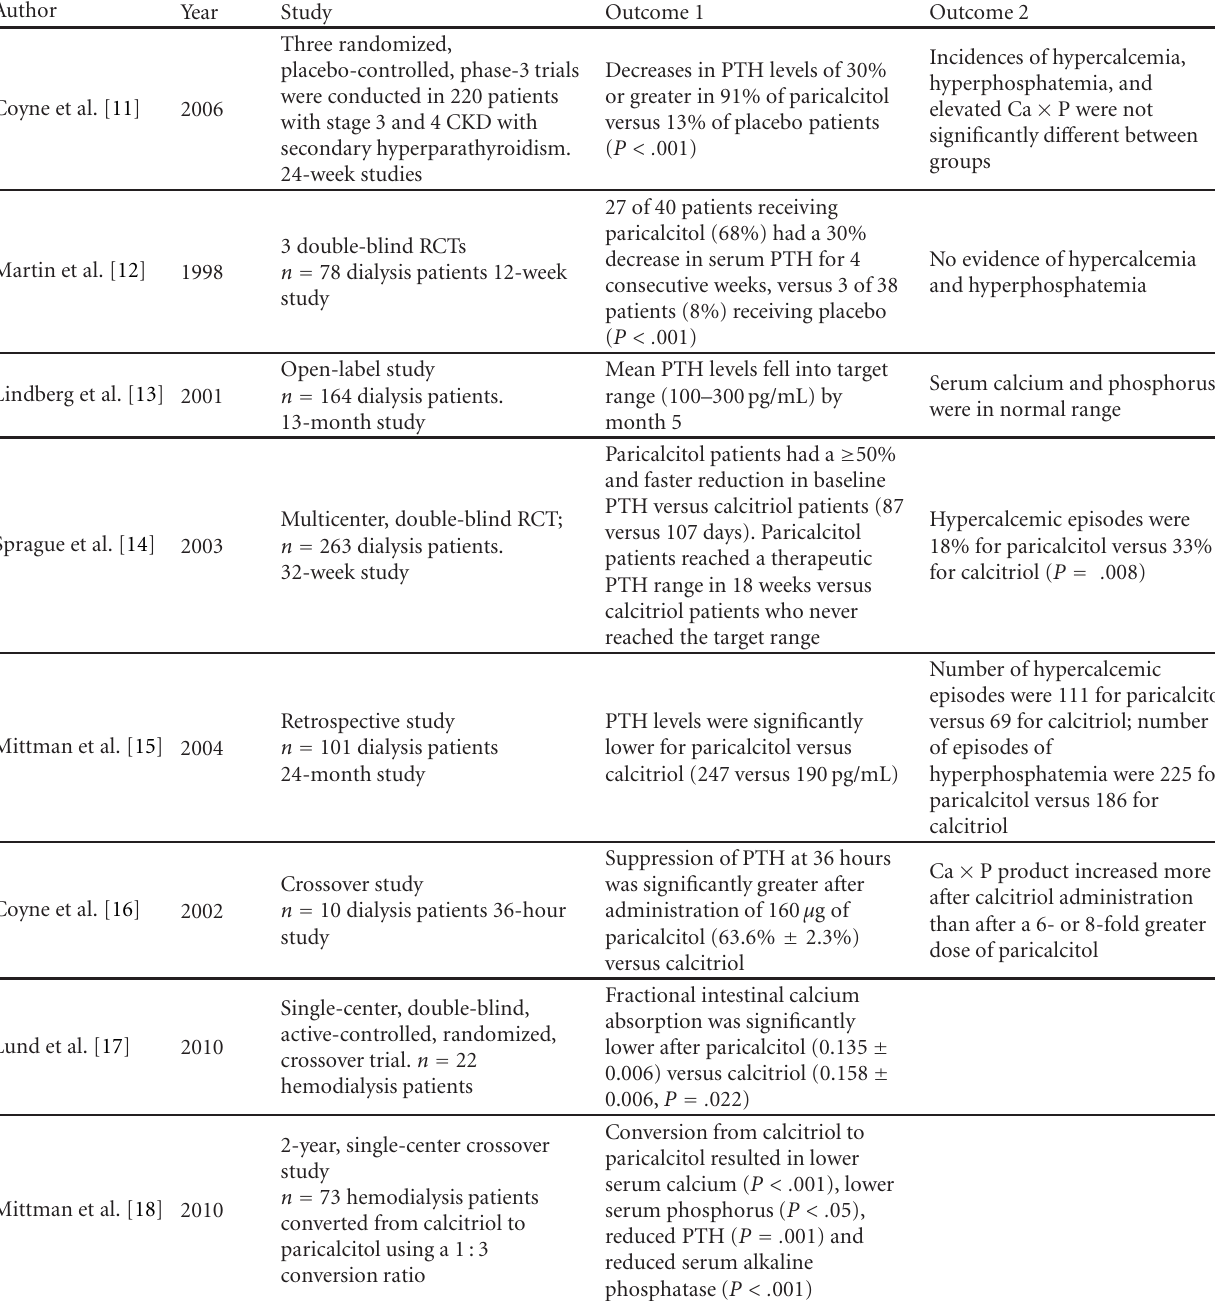
Table 2: Suppression of PTH and e ff ects on calcium and phosphate levels: paricalcitol versus placebo and paricalcitol versus